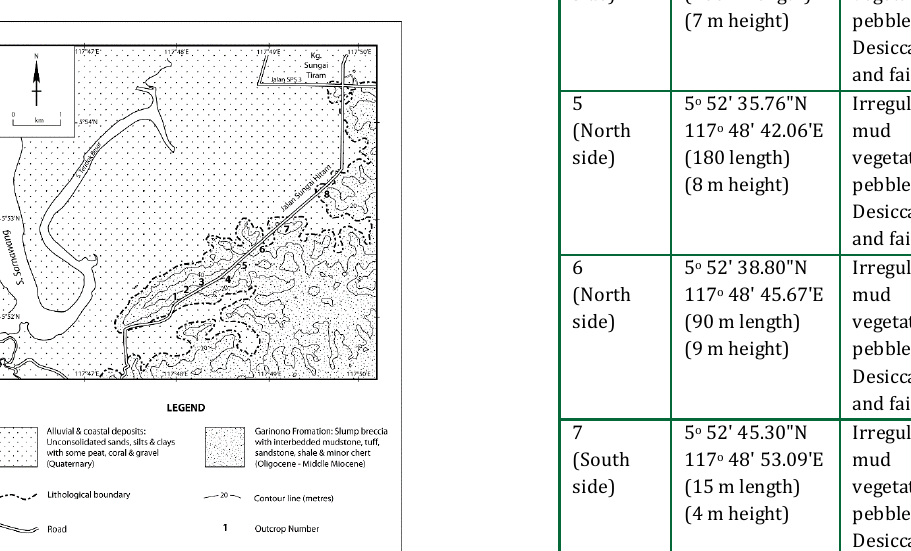
Figure 1: Geology map of the Kg. Sungai Tiram area, Libaran, Sandakan. [After Lee (1970) and field mapping]